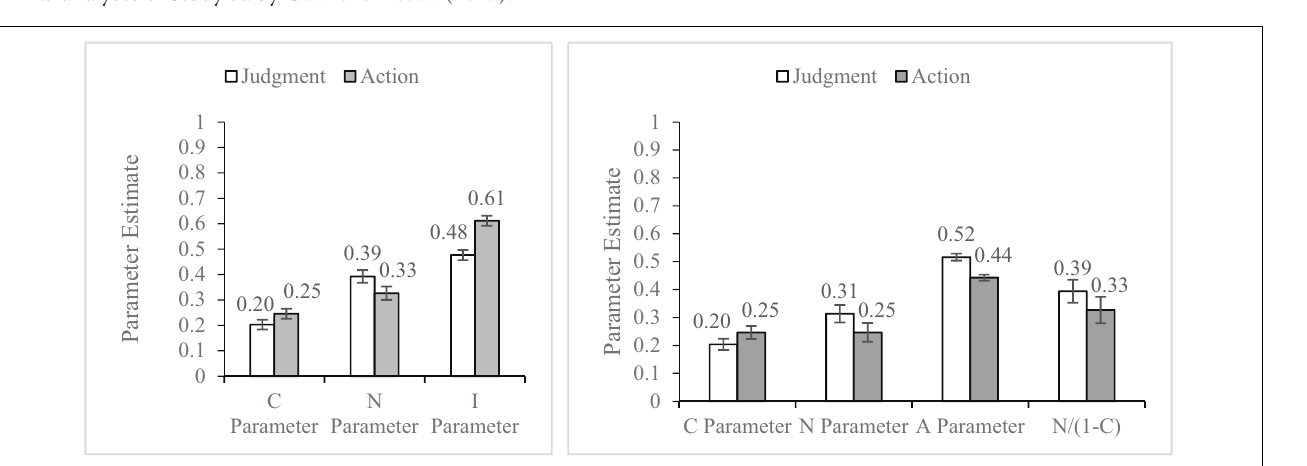
FIGURE A3 | Results of Study 3a by Gawronski et al. (2017) obtained from the CNI model (left) and CAN algorithm (right) . Error bars represent ± 1 SE.